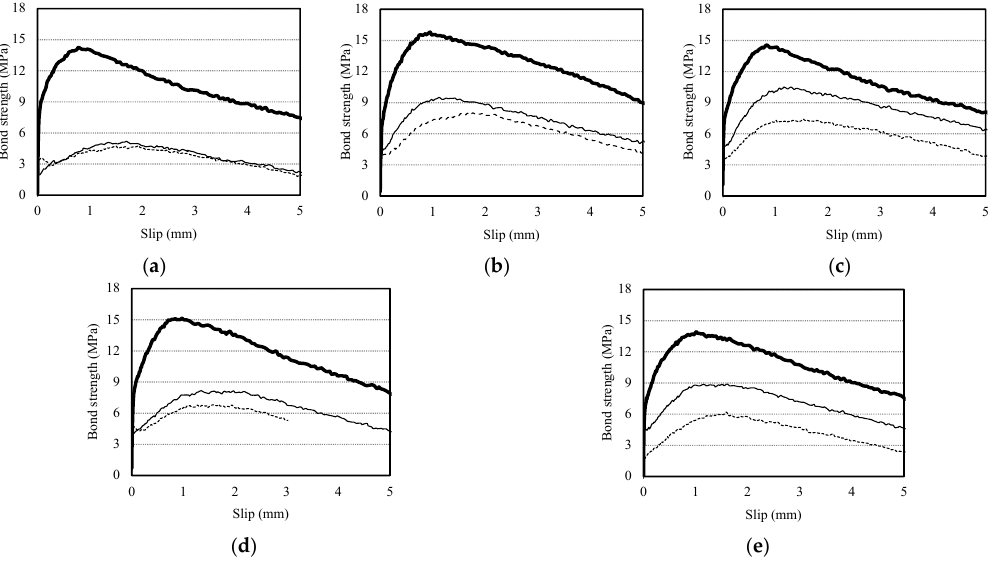
Figure 8. Bond strength-slip curve of three-tiered specimen. ( a ) G0F0R; ( b ) G15F60R; ( c ) G30F45R; ( d ) G45F30R; ( e ) G60F15R.